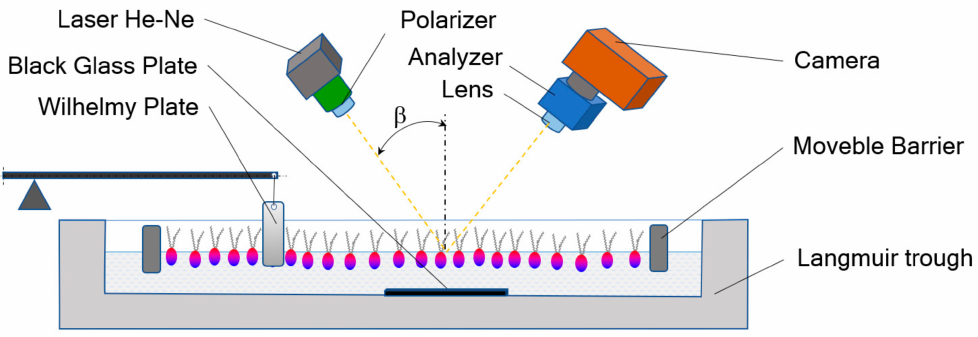
Figure 15. Schematic of the experimental setup of Brewster angle